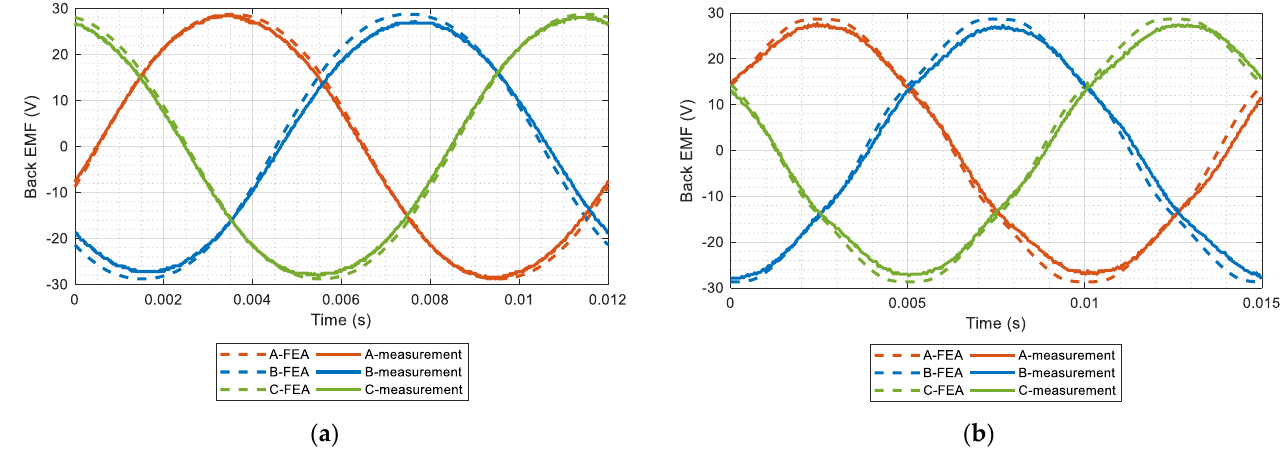
Figure 9. Comparison of the back-EMF of the winding with q = 2/5 ( a ) and q = 1/2 ( b ).